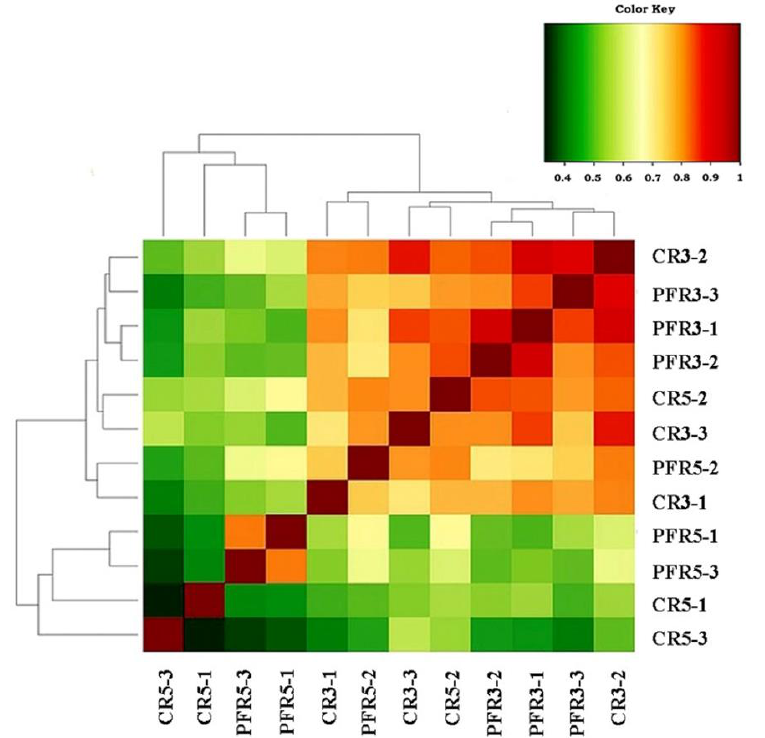
Figure 5. The correlation heatmap illustrates the relationship between each dataset of the calyx-end and peel tissues derived from bagged (i.e., CR5, PFR5) and unbagged (i.e., CR3 and PFR3) fruit and their replication compared to every other dataset. The red color indicates a close correlation, while the green color indicates a more distant correlation or given color key value exhibition ranging from 0 (complete distance) to 1 (complete close correlation) in the data.